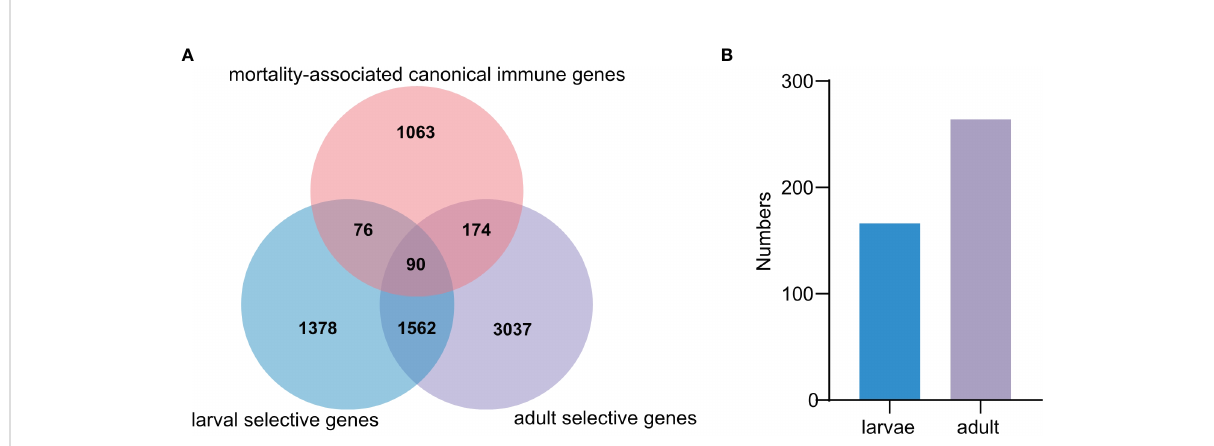
FIGURE 5 Comparative analysis of mortality-associated and canonical immune genes. (A) The Venn diagram represents the differences of mortality- associated and canonical immune genes in larvae and adult populations, respectively. (B) The number of mortality-associated genes annotated as canonical immune genes in larval and adult populations,